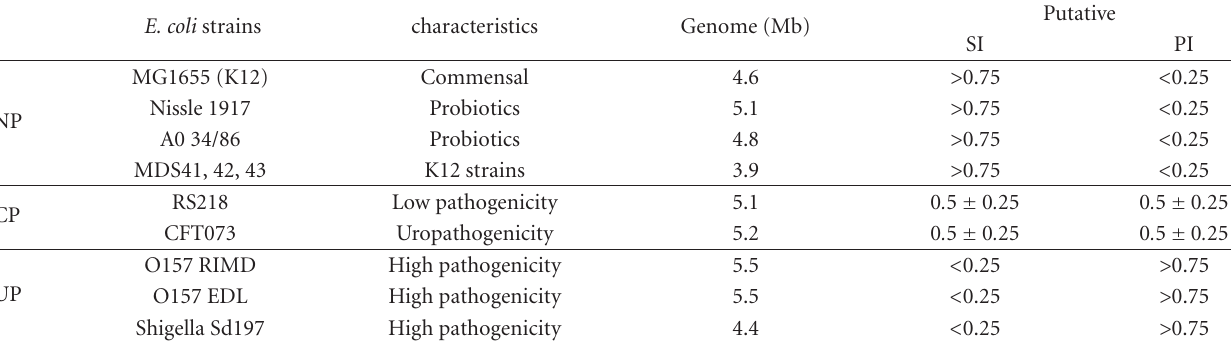
Table 1: E. coli in the three microbial communities.